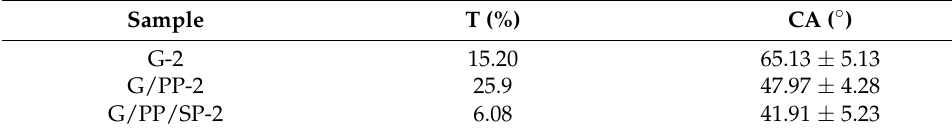
Table 2. Optical and wetting properties of edible films.